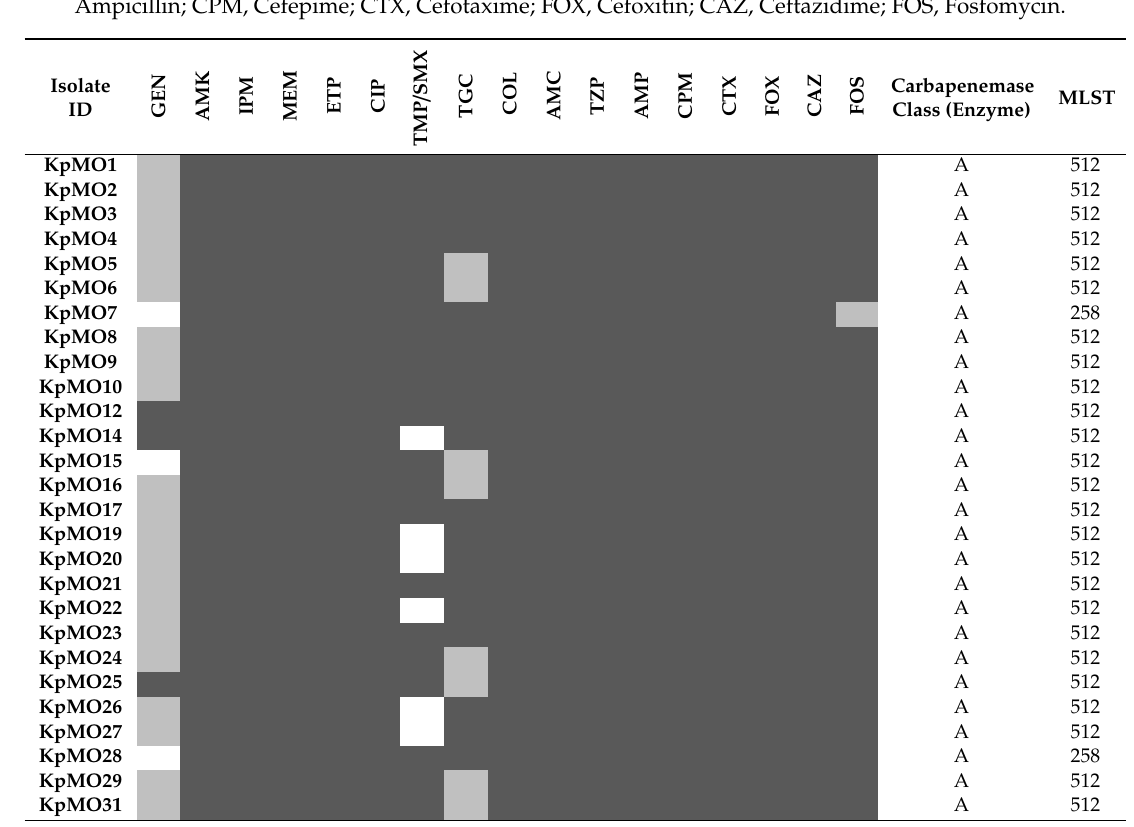
Table 1. Antimicrobial susceptibility profiles, carbapenemase class and MLST of 27 CRCR- Kp isolates. Antimicrobial susceptibility profiles: dark grey, grey, and white colors represent resistant, intermediate and sensitive strains respectively. GEN, Gentamicin; AMK, Amikacin; IPM, Imipenem; MEM, Meropenem; ETP, Ertapenem; CIP, Ciprofloxacin; TMP / SMX, Trimethoprim / Sulphonamide; TGC, Tigecycline; COL, Colistin; AMC, Amoxicillin clavulanate; TZP, Piperacillin / Tazobactam; AMP, Ampicillin; CPM, Cefepime; CTX, Cefotaxime; FOX, Cefoxitin; CAZ, Ceftazidime; FOS, Fosfomycin.